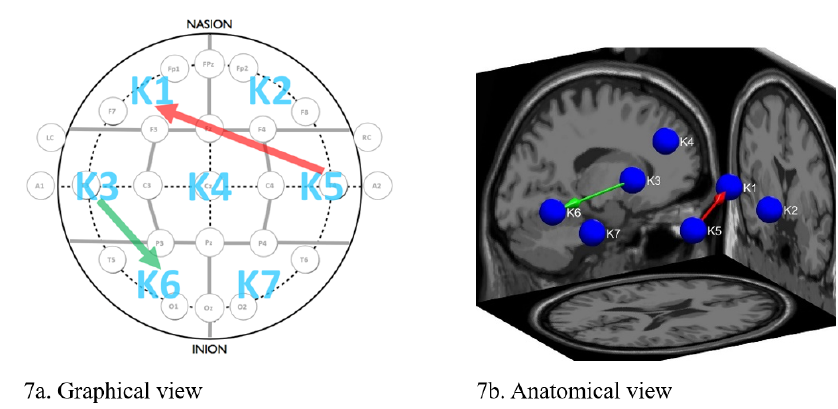
Figure 7. Estimated brain connectivity in the resolution-reaching phase for numerical intelligence tasks.